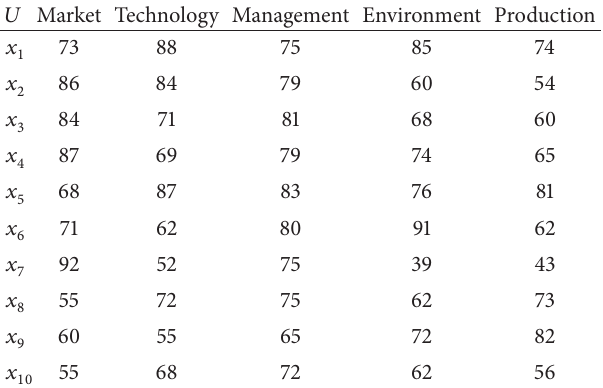
Table 1: An information system about fund